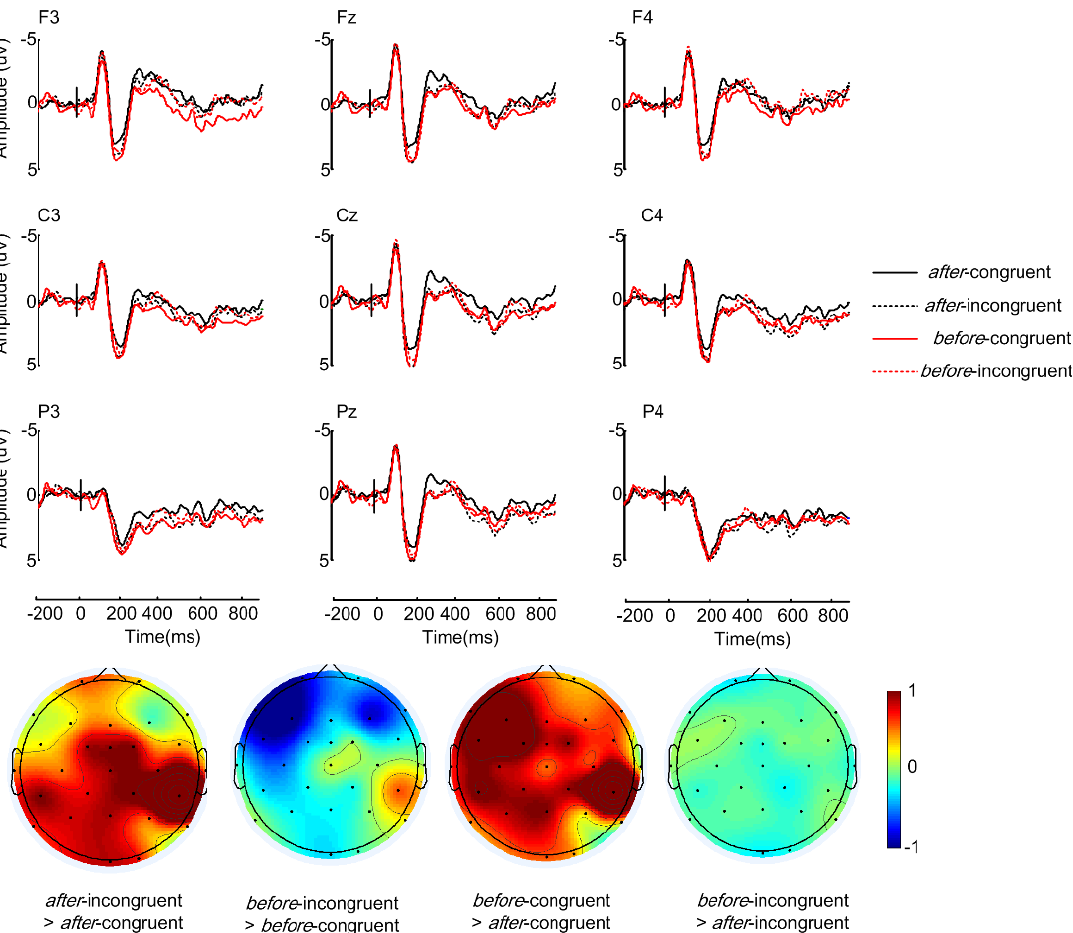
Figure 1. ERP results to the critical words in each of the four conditions at 9 representative electrodes are shown in the graph. Scalp distributions of the relevant difference effects (in the 300–800 ms time window) are given below the ERP graph.